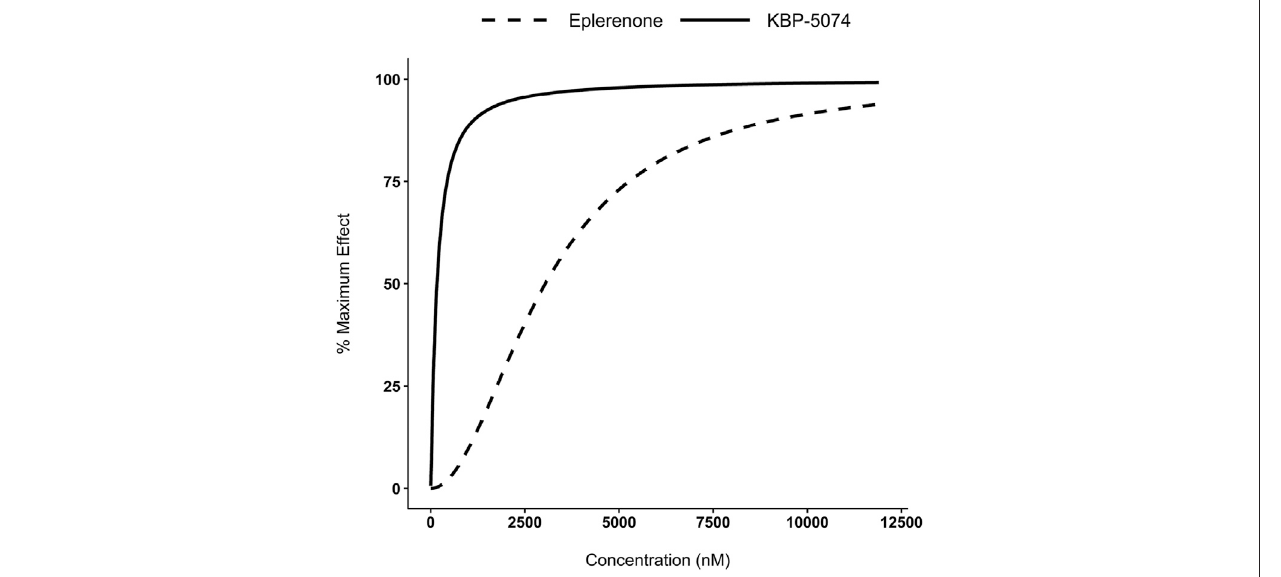
FIGURE 4 | PK/PD modeling of urinary Na + /K + ratios. Concentration-effect curves of simulated Na + /K + ratios as a function of eplerenone and KBP-5074 concentrations. The Na + /K + ratio data were normalized to range from 0% (baseline response) to 100% (maximum response).